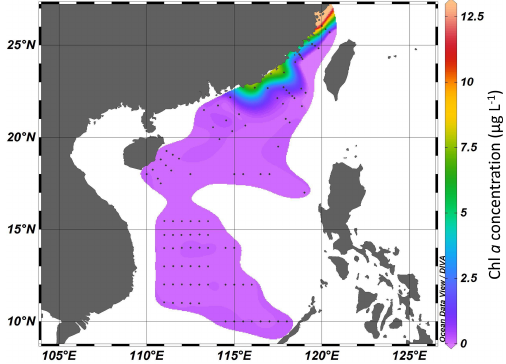
Figure 5. Seawater-acidification-induced (pH decreases of 0.4 units) changes (%) of surface primary productivity in the Taiwan Strait and the South China Sea. Red–yellow shading repre- sents a positive effect on PP, and blue–purple shading represents a negative effect.